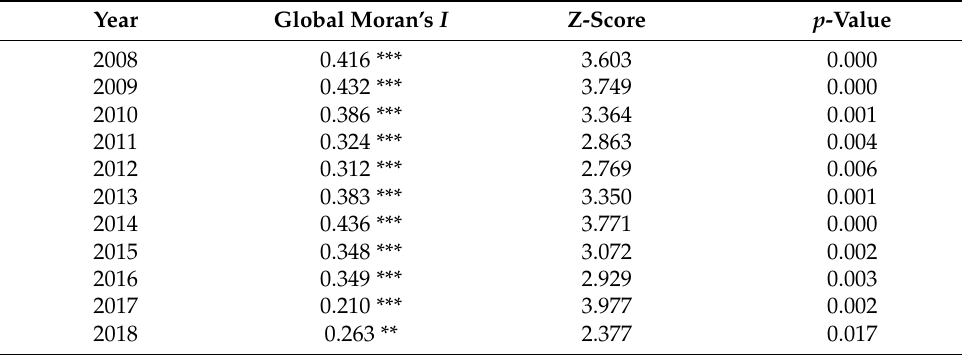
Table 6. Value of Global Moran’s I of provincial ULGLE in China (2008–2018).